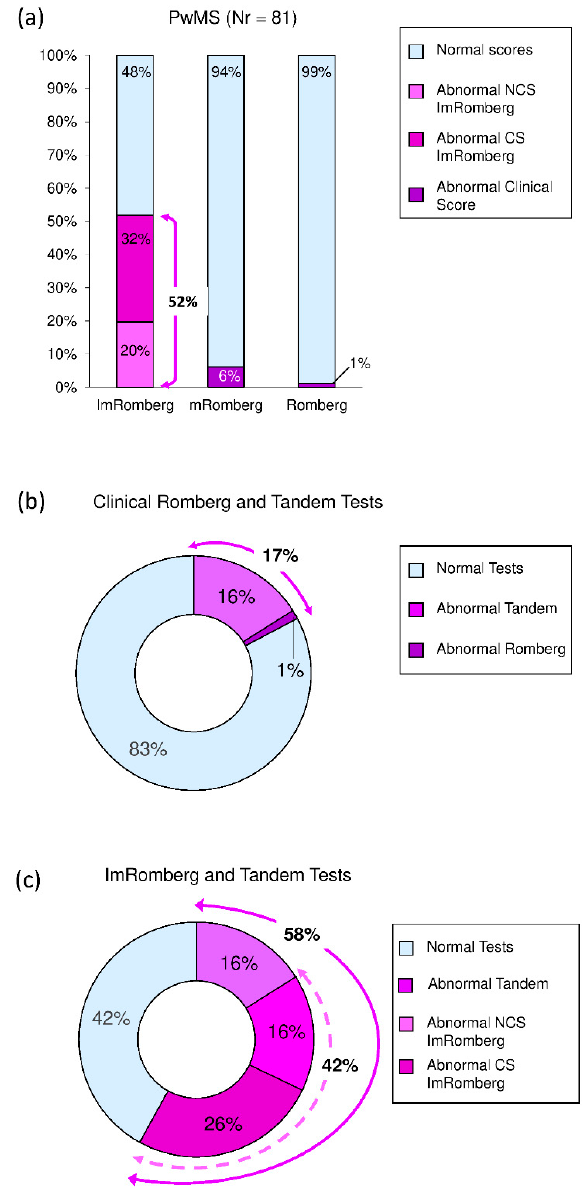
Figure 3. ( a ) Percentage of people with MS (PwMS) showing abnormal ImRomberg test and abnormal clinical scores on modified Romberg (mRomberg) and Romberg tests. ( b ) Percentage of PwMS with abnormal tandem gait test (light violet) and with normal tandem but abnormal clinical Romberg test (dark violet). ( c ) Percentage of PwMS with abnormal tandem gait test (light violet) and with normal tandem but abnormal ImRomberg (light and dark magenta). ImRomberg was considered abnormal in case of sway complexity and/or sway intensity score outside normative cut-offs (two-headed dashed arrow). Abnormal NCS: abnormal, not clinically significant (sway complexity and/or sway intensity outside normative cut-offs but inside clinically significant cut-offs); abnormal CS: abnormal, clinically significant (sway complexity and/or sway intensity outside clinically significant cut-offs).